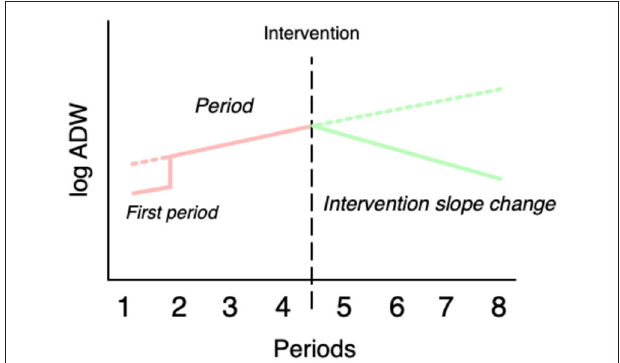
FIGURE 1 | Schematic illustration of the variables used in the main regression